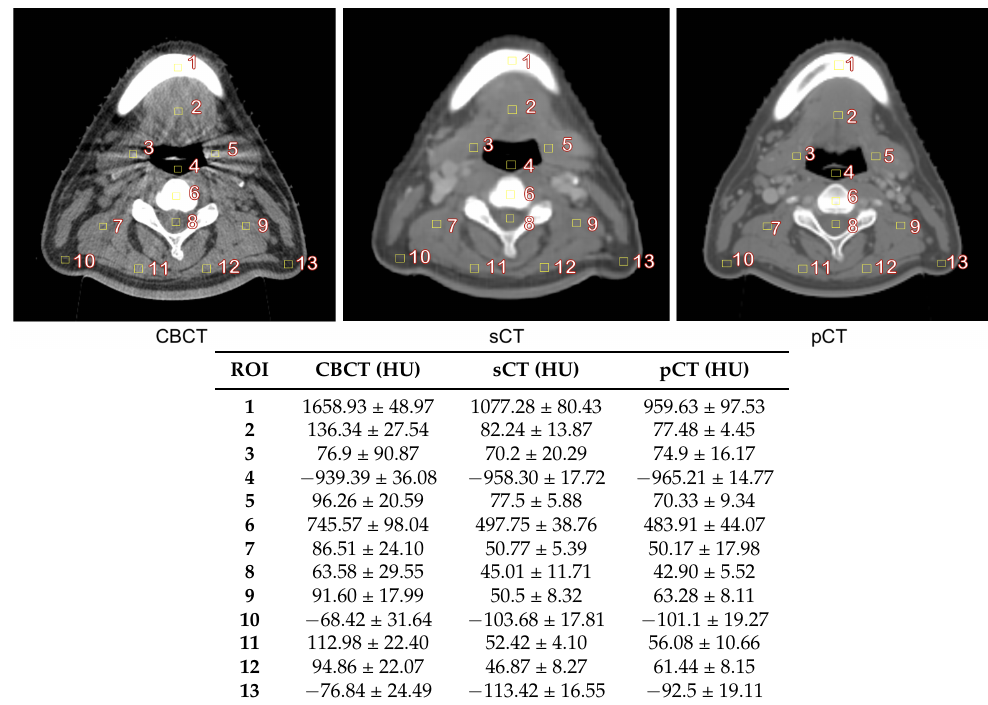
Figure 9. Hounsfield unit (HU) values at different ROIs on CBCT, sCT, and pCT. Values are shown in terms of mean ± standard